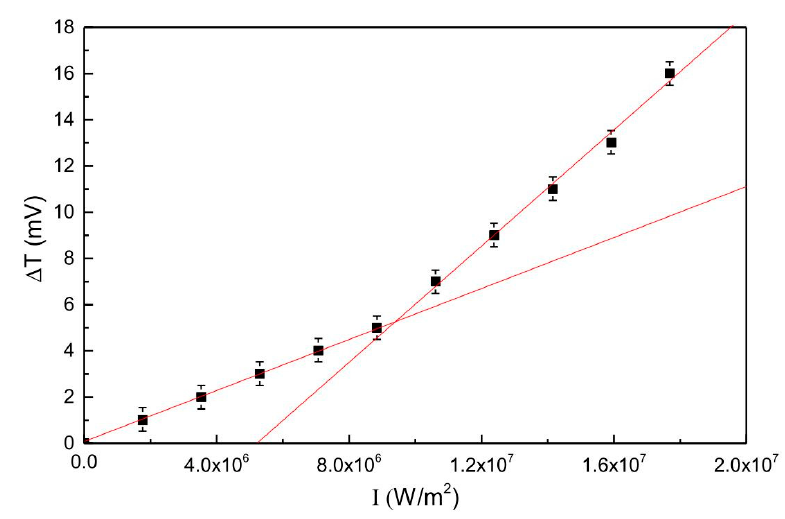
Figure 5. Transmitted probe signal vs. pump light intensity. A threshold-less response of the LC molecular director is clearly observed. The curve slope changes in correspondence of a light intensity I = 1.1 × 10 7 W/m 2 .